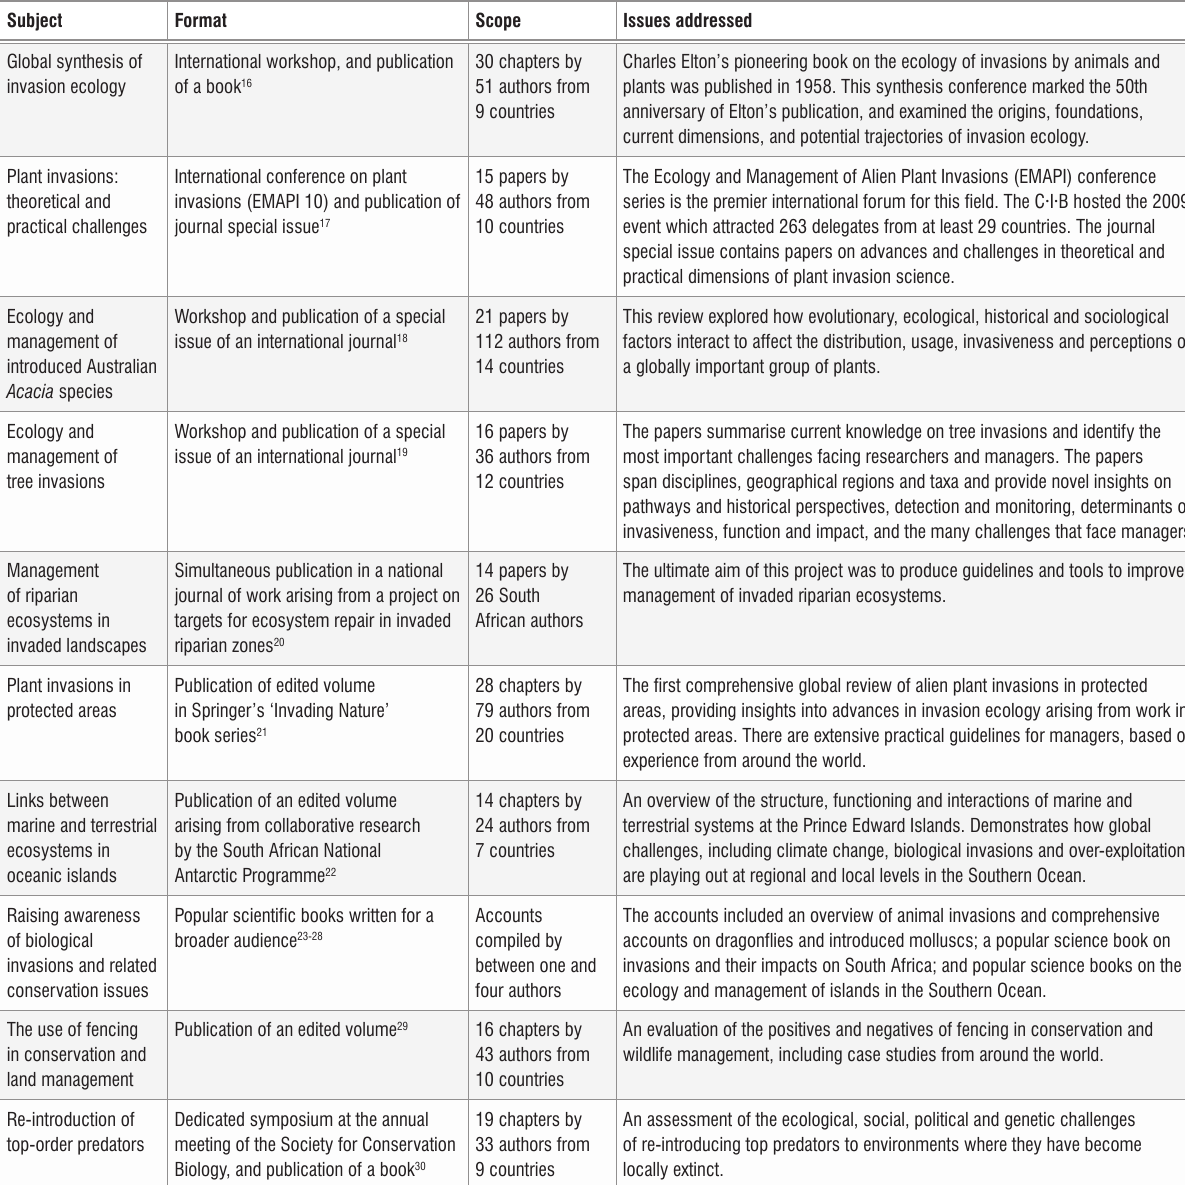
Examples of scientific compilations that have advanced understanding and raised awareness of biological invasions in South Africa and